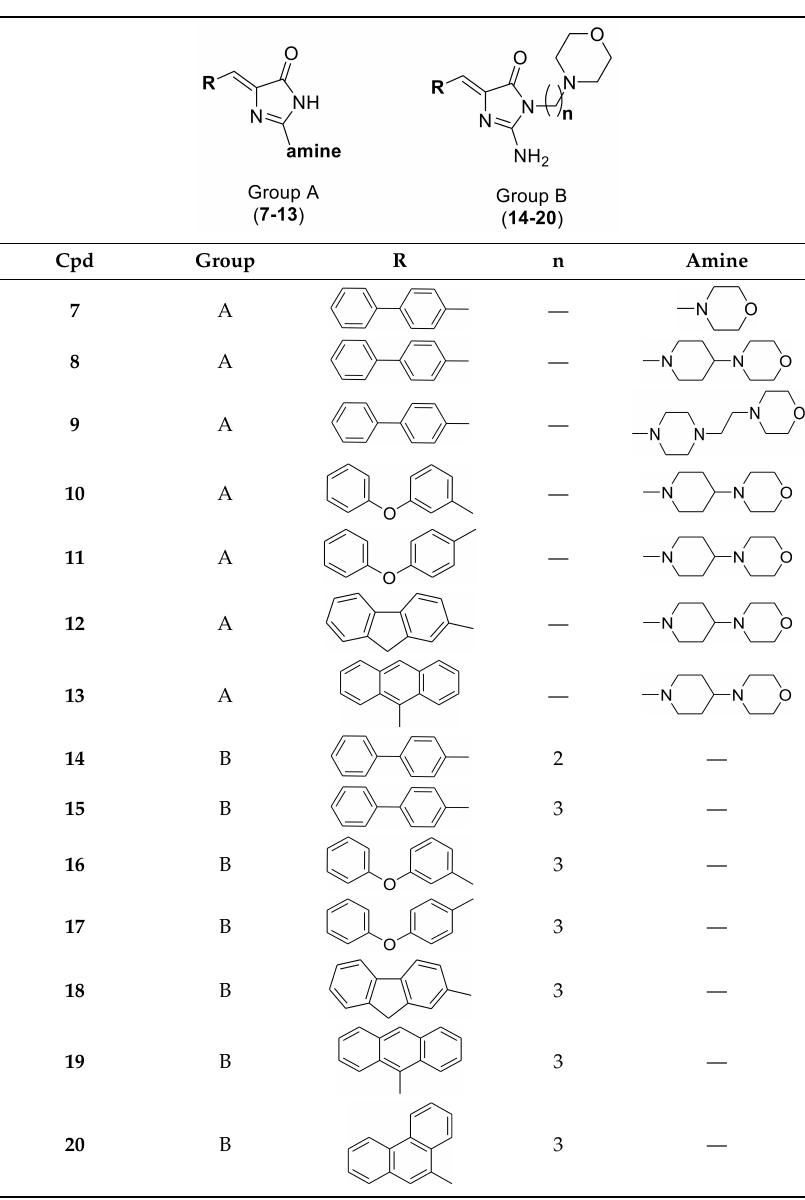
Table 1. Structures of tested 5-arylideneimidazolones ( 7 – 20